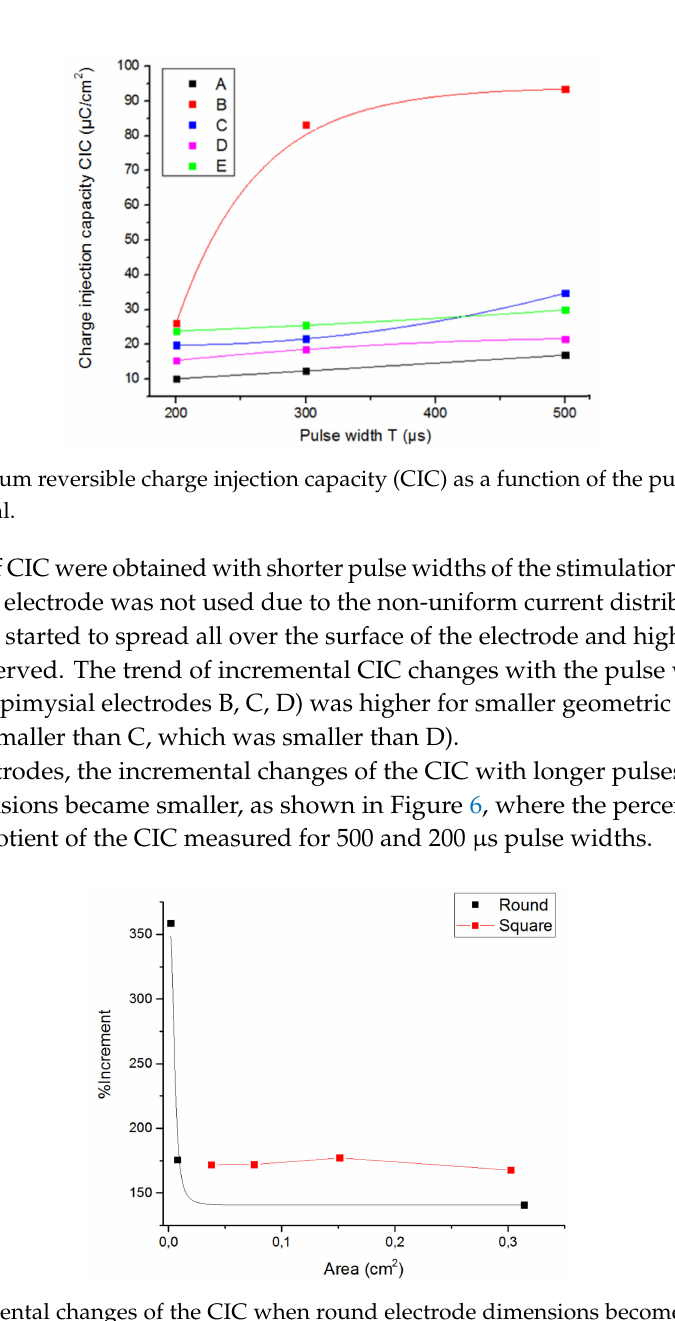
Figure 6. Incremental changes of the CIC when round electrode dimensions become smaller. Black line: round epimysial electrodes B, C, D; Red line: Pt foil square electrode